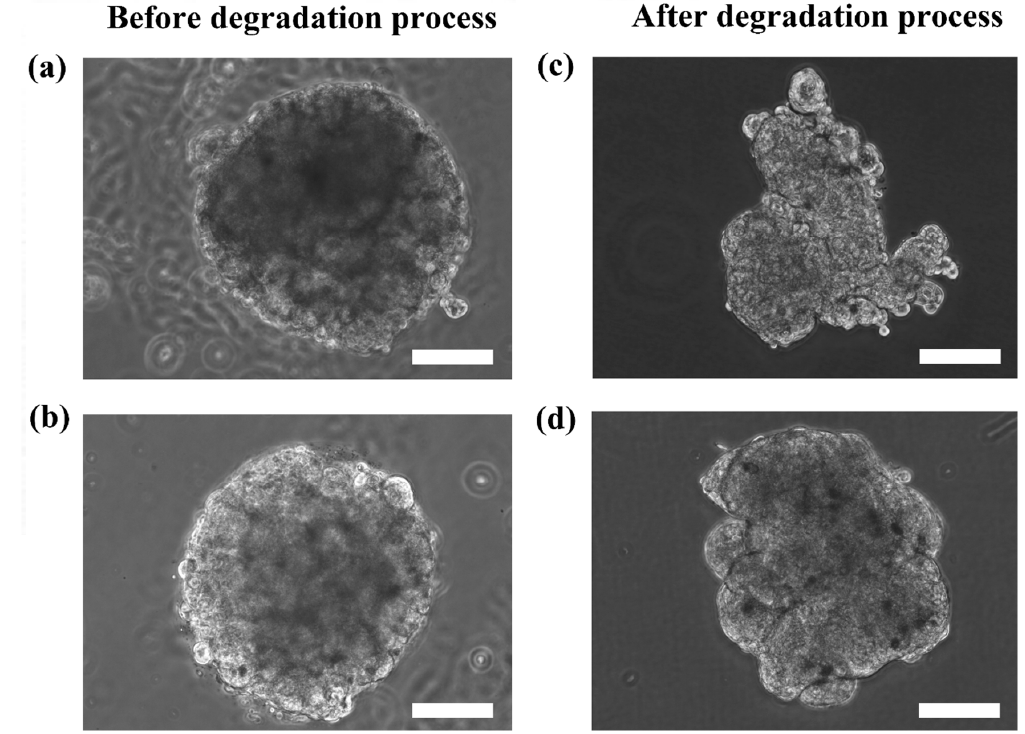
Figure 5. Phase contrast microscopic images of the calcium alginate encapsulated with ( a ) HaCaT and ( b ) ORL-48 microtissues before alginate degradation, and the extracted ( c ) HaCaT and ( d ) ORL-48 microtissue after alginate degradation at 100× magnification (Scale bar: 100 μ m).